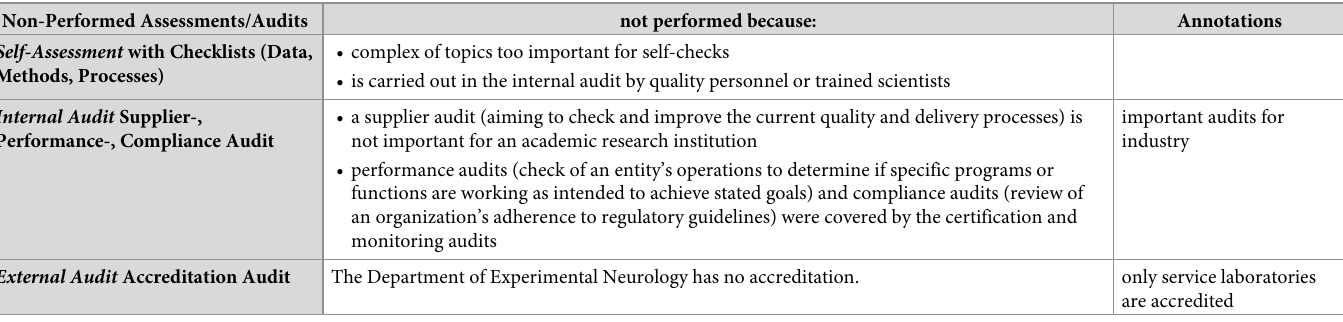
Table 3. Examples for types of audits and assessments, which were considered, but not performed at the Department of Experimental Neurology. Non-Performed Assessments/Audits not performed because: Self-Assessment with Checklists (Data, Methods,